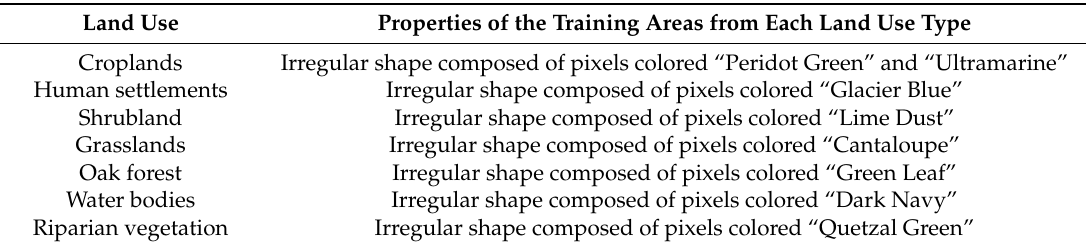
Table 2. Definition of land uses for the study area and properties of corresponding training